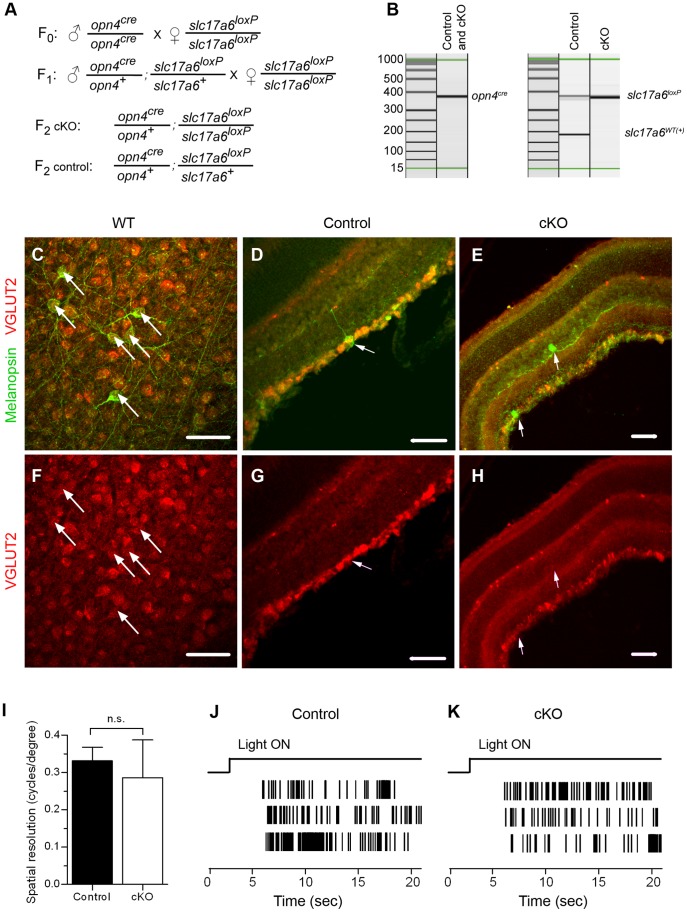
Conditional knockout of VGLUT2 from mRGCs.(A) Breeding scheme for obtaining conditional VGLUT2 knockouts (cKO) and controls. (B) Mice were genotyped by PCR with allele-specific primers. (C–H) VGLUT2 immunoreactivity is detected in melanopsin-immunoreactive retinal ganglion cells in wild-type (WT) (C, F) and control mice (D, G) but not cKO mice (E, H). (C, F) flatmount retina; (D, E, G, H) retinal slices. Arrows point to retinal ganglion cells that are immunopositive for melanopsin. Scale bar: 50 um. (I) Mean optokinetic response, a measure of image-forming vision, was not different between control (n = 8 eyes) and cKO (n = 7 eyes) mice (P = 0.4, Student’s t-test). (J, K) Typical action potential responses of neonatal (P8) mRGCs to light in control (J) and cKO (J) retinas. These electrophysiological findings demonstrate that mRGCs in VGLUT2 cKO pups retained their light responses.